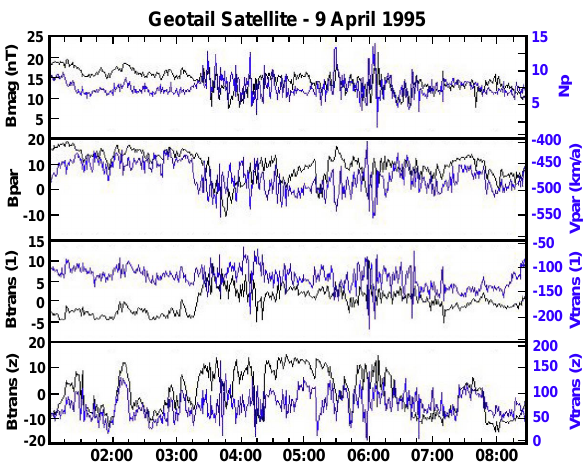
Fig. 15. Geotail magnetosheath data in the central region of the high speed stream on 9 April 1995. Top panel: magnetic field and density; bottom three panels: field-aligned and perpendicular com- ponents of b and v .